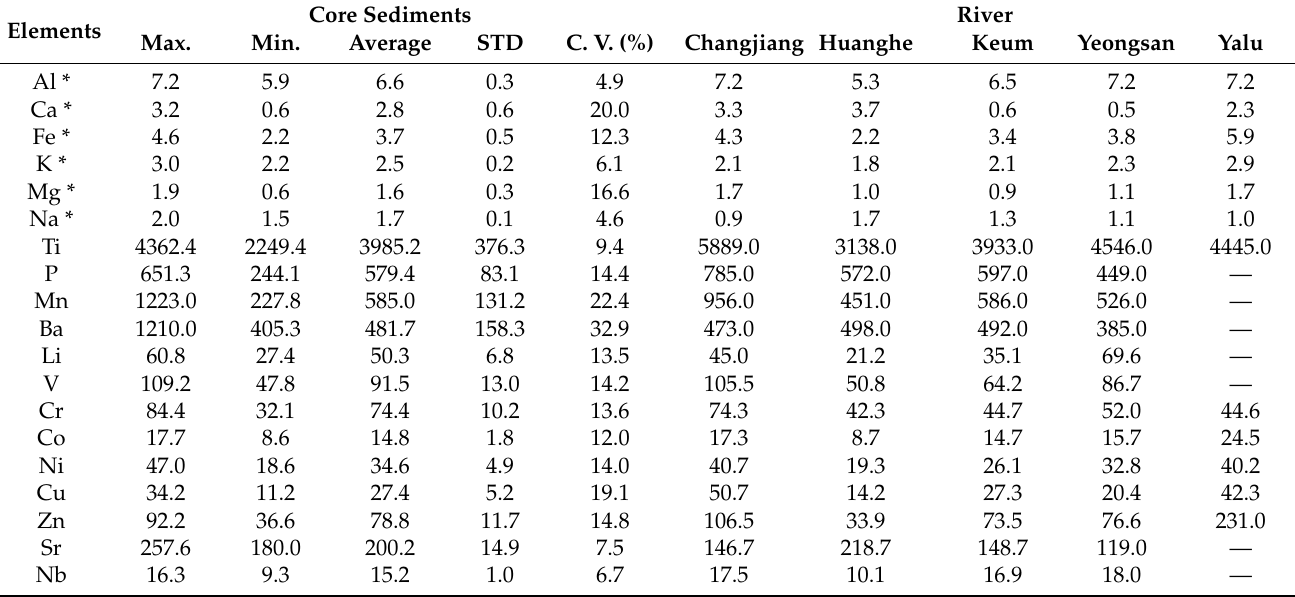
Table 3. Comparison of element composition between the Core sediments and river